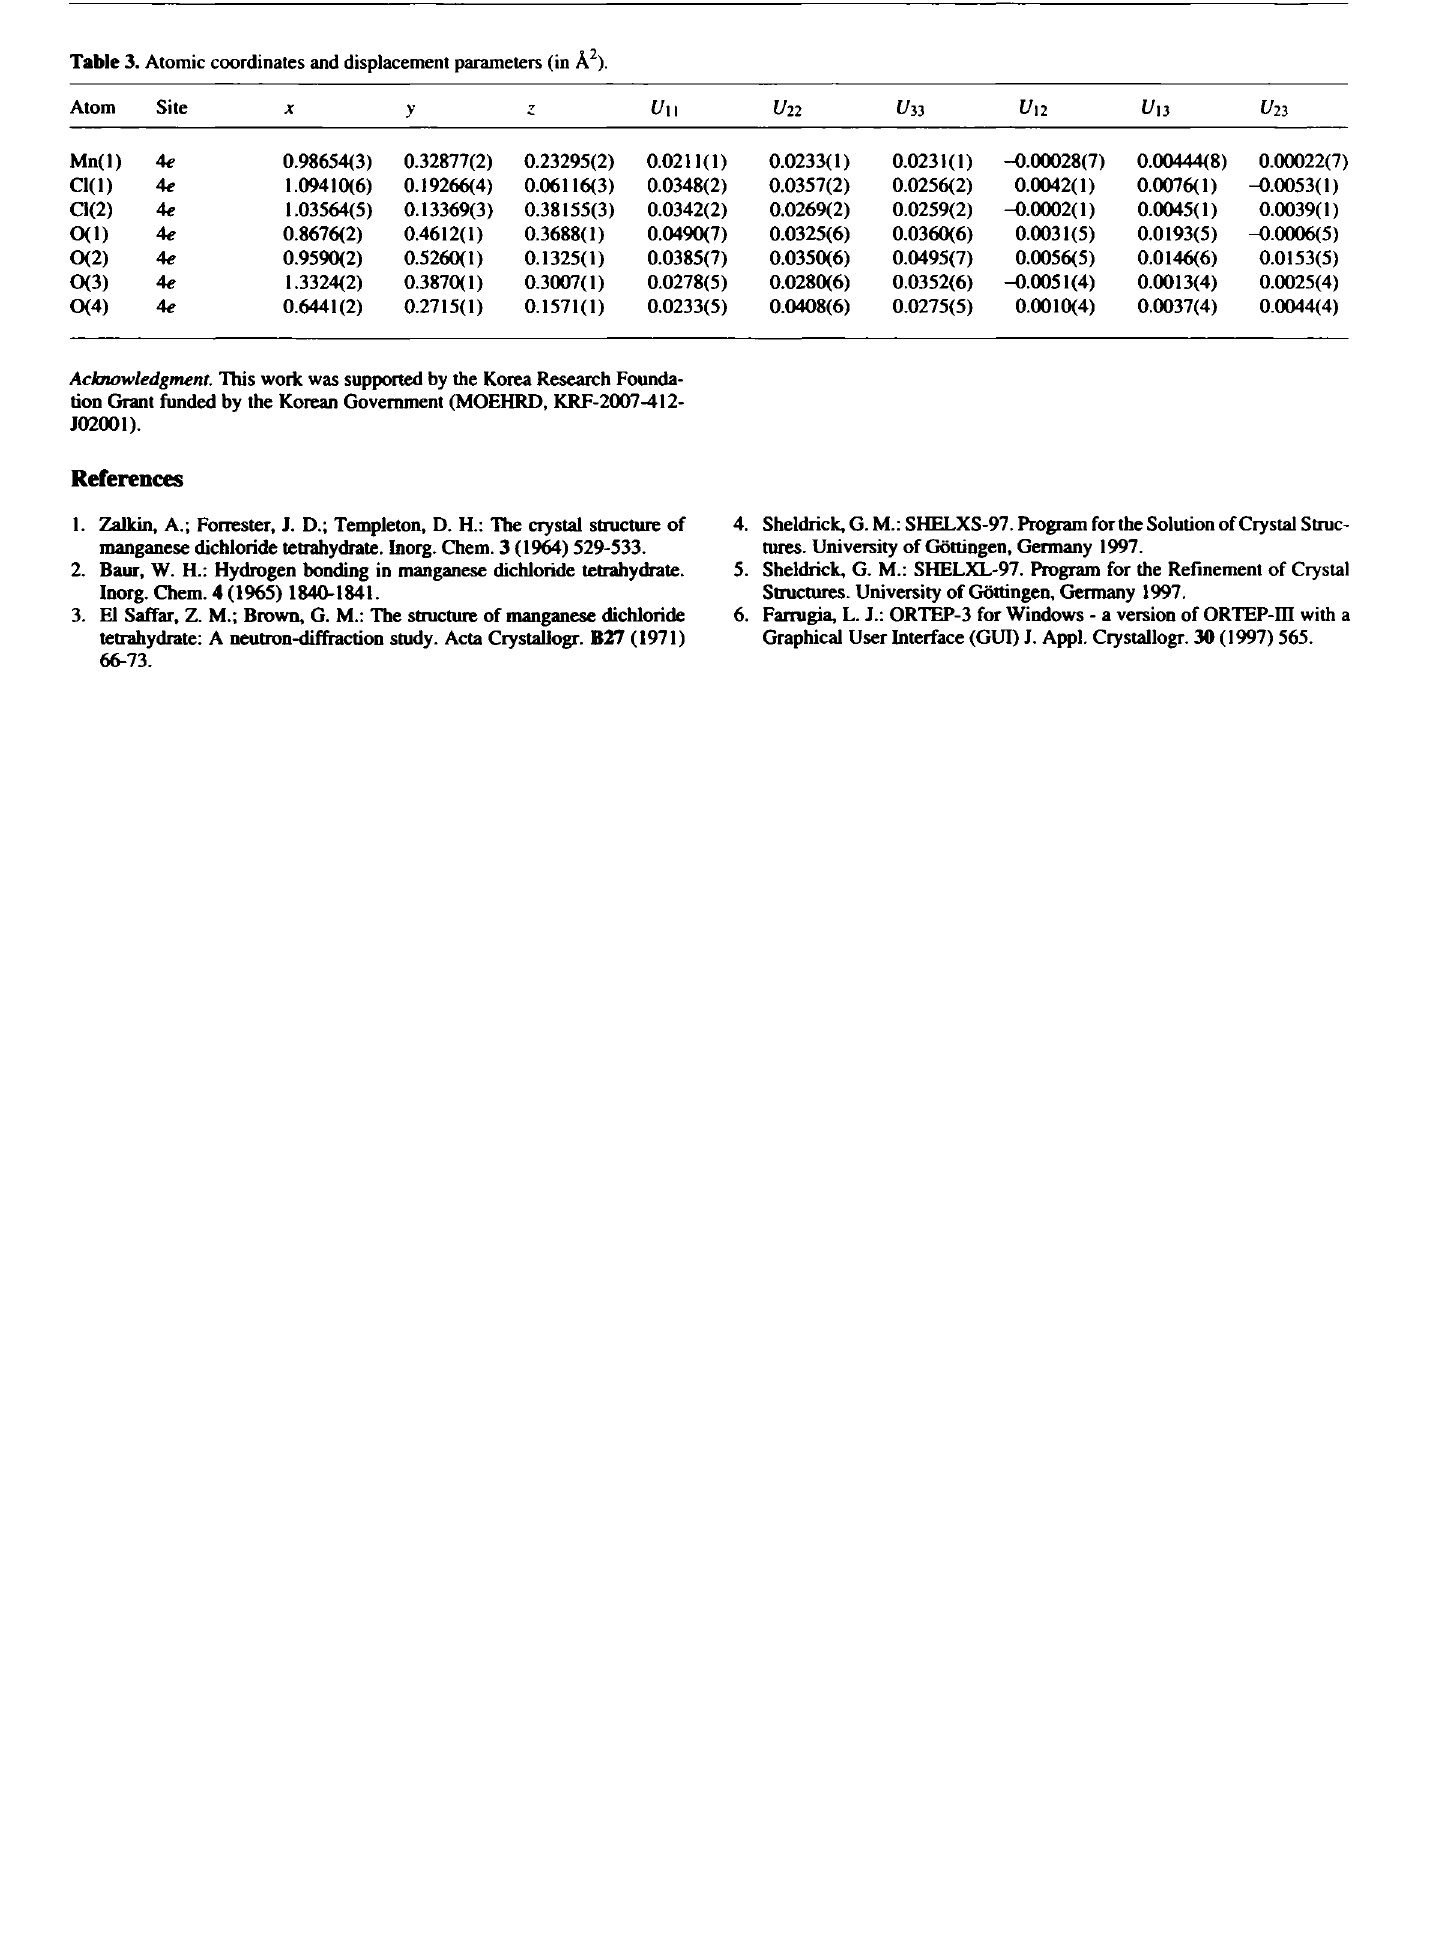
Table 3. Atomic coordinates and displacement parameters (in À 2